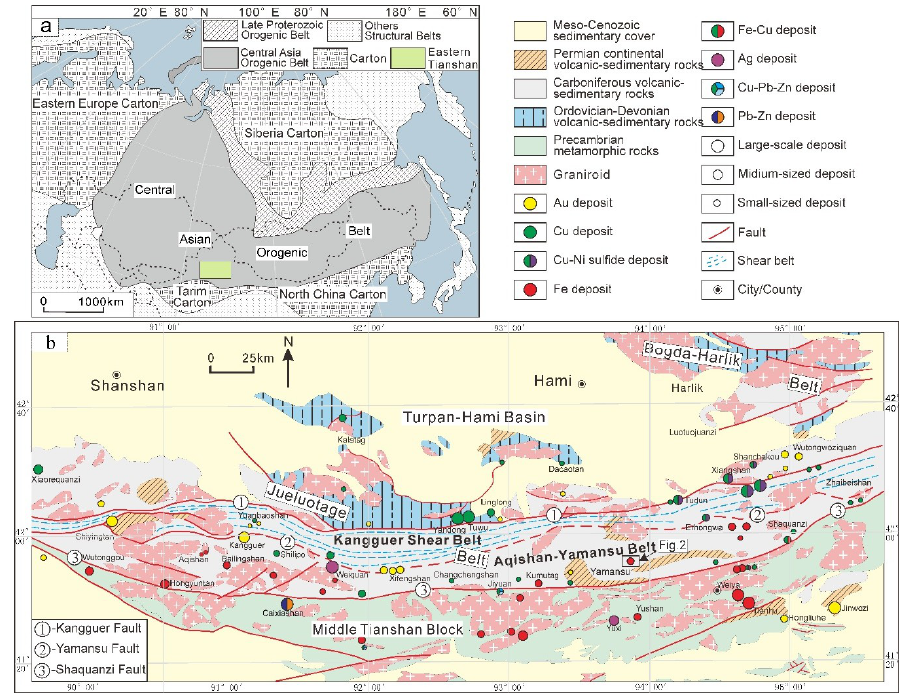
Figure 1. Tectonic sketch geological map of the Central Asian Orogenic Belt ( a ) and geological map with deposit distributions in the Eastern Tianshan Orogenic Belt ( b ), modified after [16].